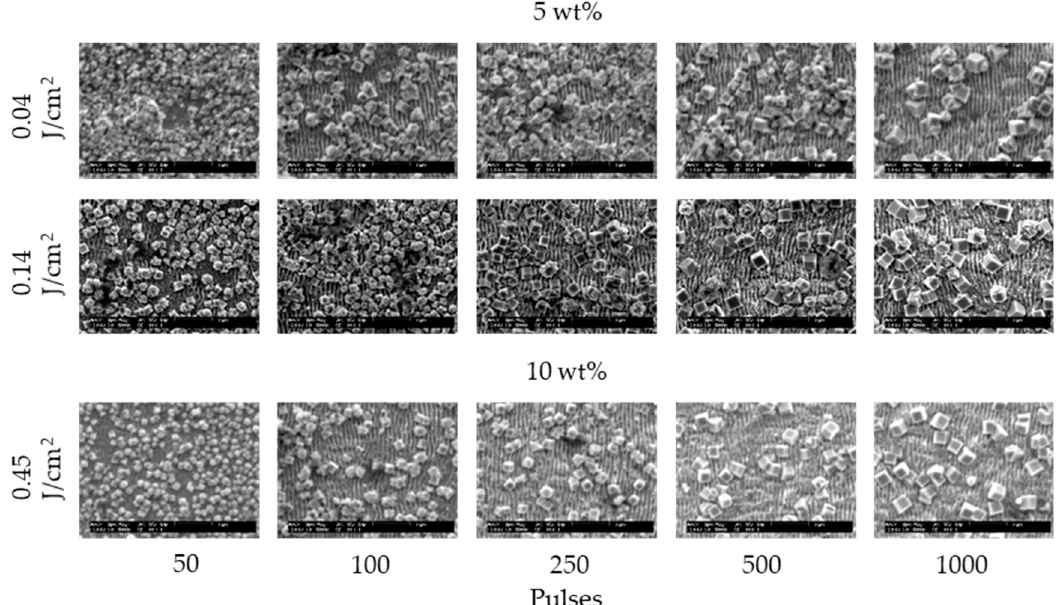
Figure 7. SEM images of 304 stainless steel irradiated with N = 50–1000 pulses at F = 0.04–0.45 J/cm 2 in 5 and 10 wt% CuSO 4 solutions. The laser beam has the polarization in a lateral direction.